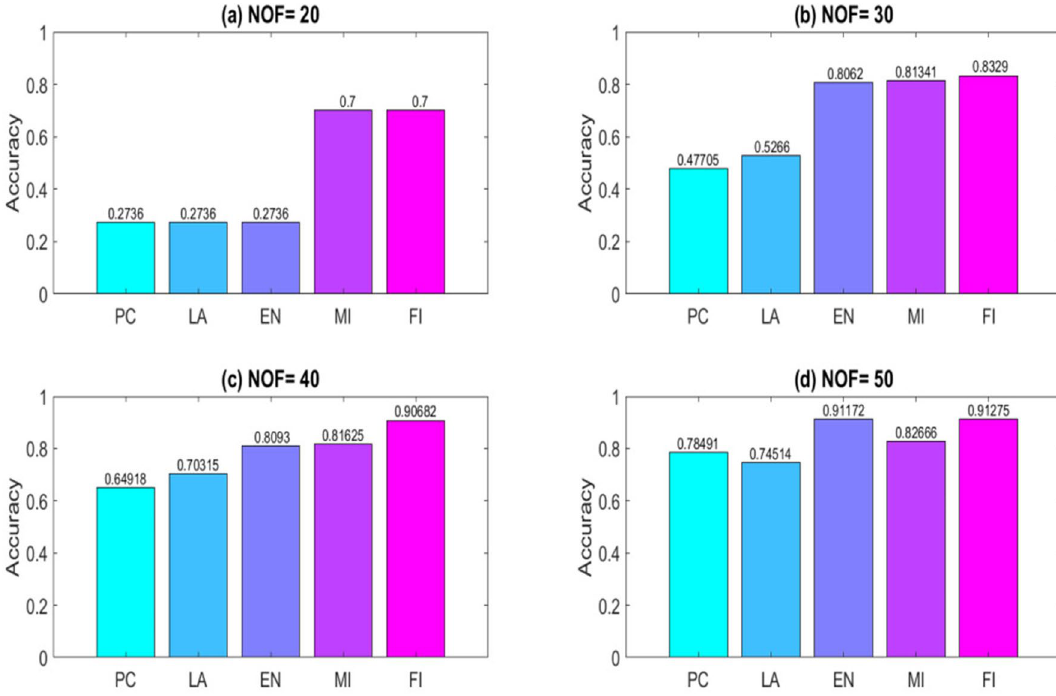
Figure 16. Outcomes of the filter FS methods on the Diabetes dataset with selecting ( a ) 20, ( b ) 30, ( c ) 40, and ( d ) 50 features. The confining total number of features may lead to different results. PC, Pearson correlation; LA, Laplacian score; EN, entropy; MI, mutual information; FI, Fisher score.